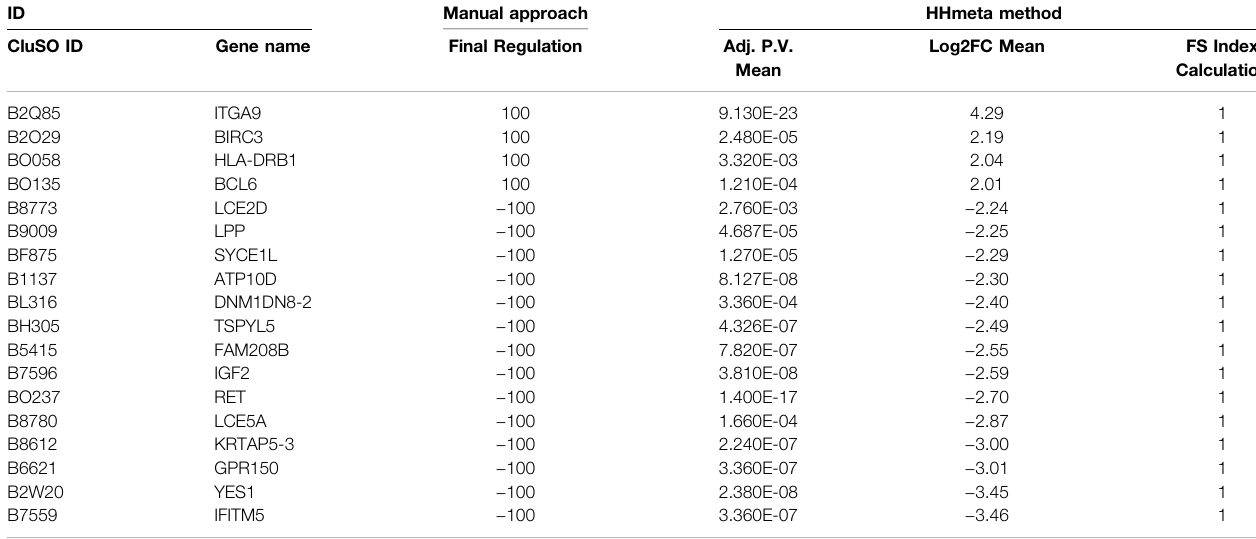
TABLE 2 | Top deregulated molecules obtained with the Manual approach and FS Index